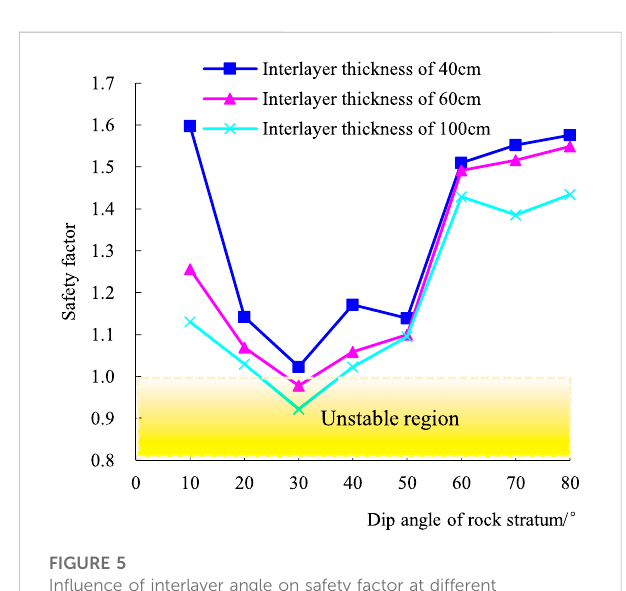
FIGURE 5 In fl uence of interlayer angle on safety factor at different interlayer thickness.